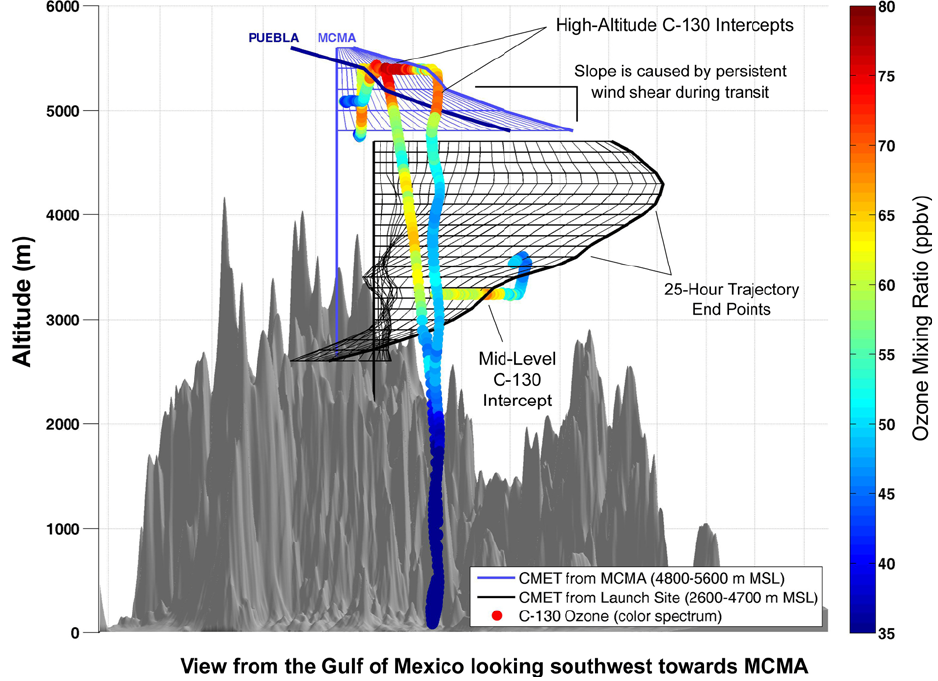
Fig. 14. Elevation view of the balloon-based trajectories and C-130 ozone measurements (in color) for the 18–19 March MCMA outflow event. The constant-altitude trajectories (horizontal blue lines above and black below) extend from MCMA in the background towards the viewer. The mesh is created by the 1-h time-interval lines, the last of which is the locus of 25-h end points shown as bold lines on the right. The diagonal structure in the high-altitude ozone field (red band) closely matches the slope of the blue end-position line, an indication that the balloon-based trajectories accurately describe the actual transport. Trajectories from Puebla, while much less certain than those from MCMA, are shown as their end position only (in dark blue) to give a sense of the uncertainty in source attribution.